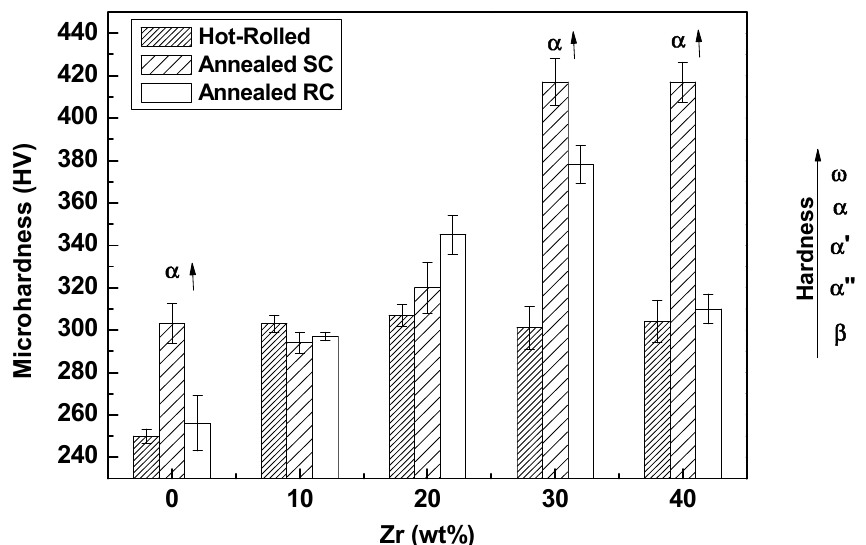
Figure 4. Vickers microhardness values of Ti-25Ta-Zr system alloys after hot-rolling and heat treatments, annealing with slow (SC) and rapid cooling (RC).